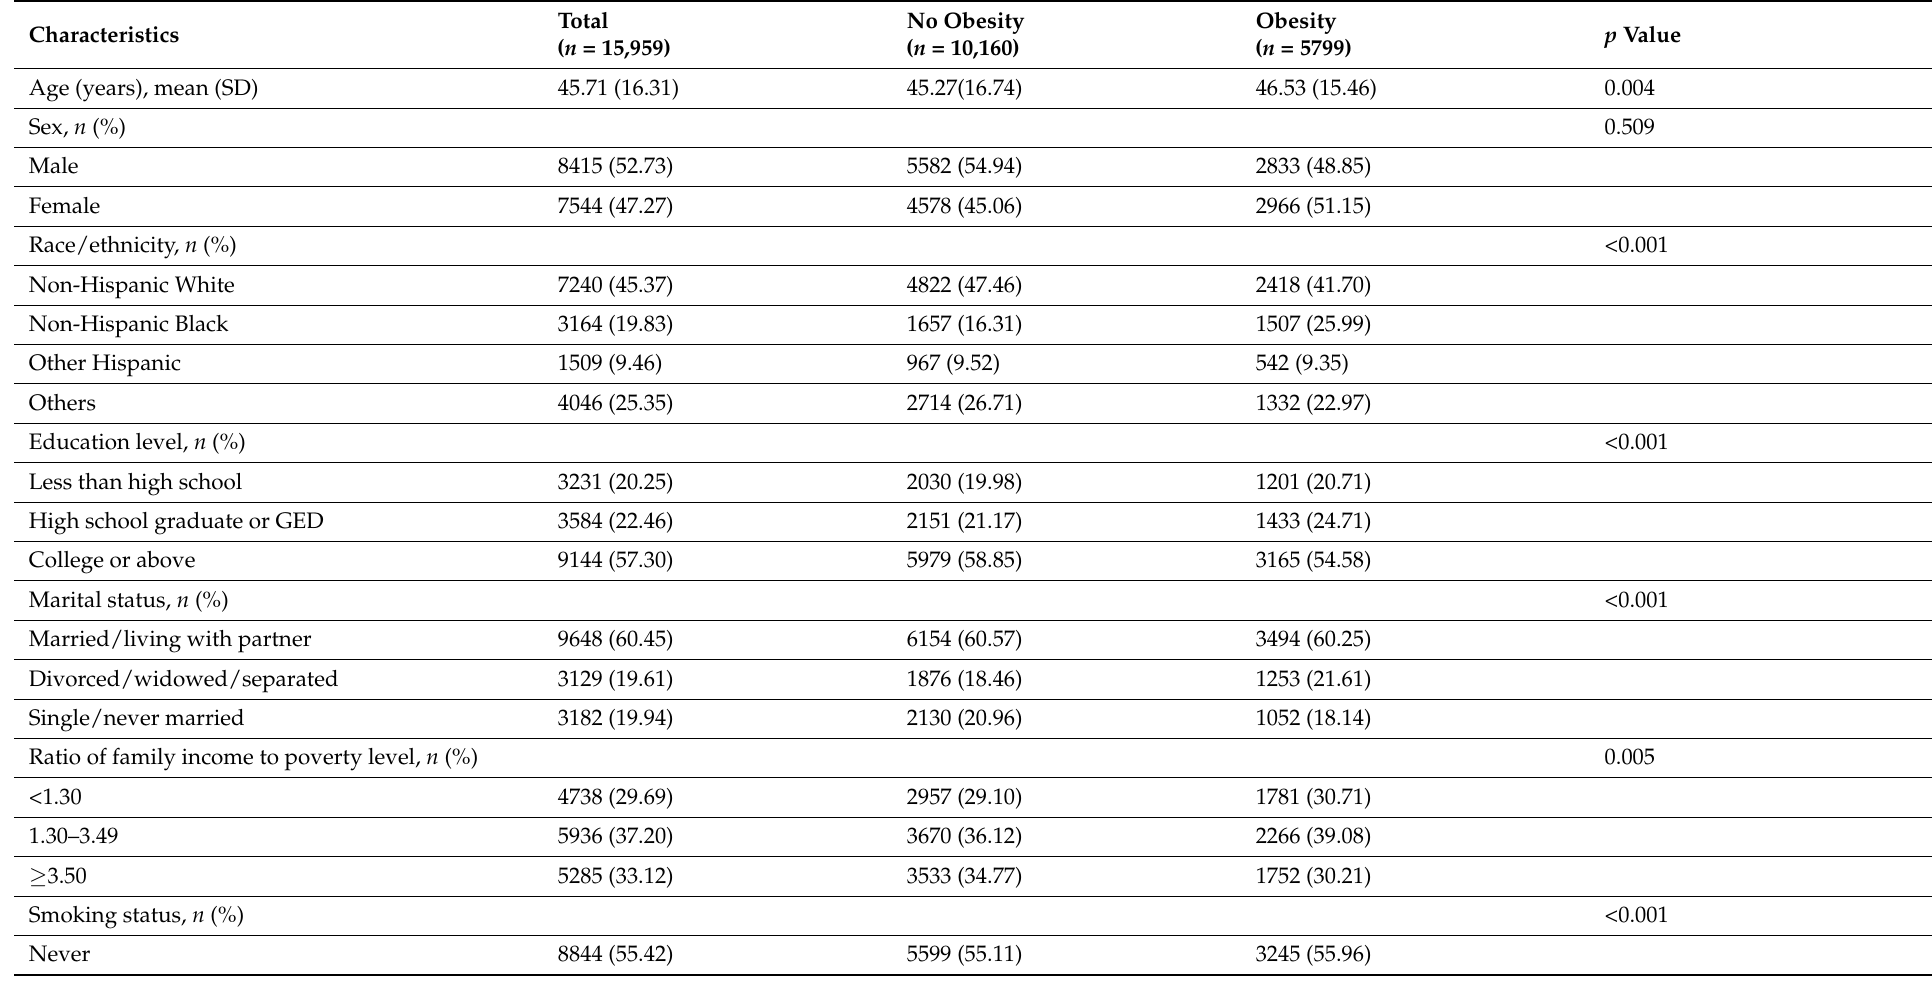
Table 1. Demographic characteristics of the NHANES 2007–2018 participants ( n =